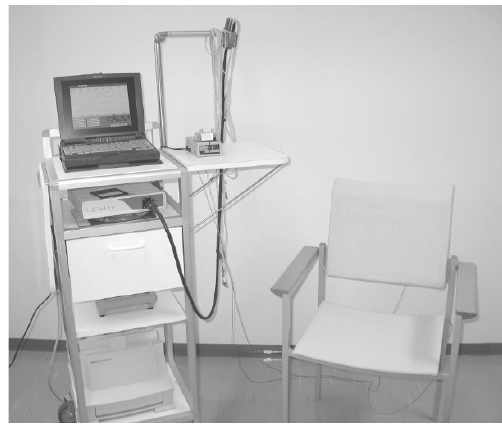
Figure 2: A chair equipped with an EMFi-film sensor, the charge amplifier, a CircMon device, and a laptop